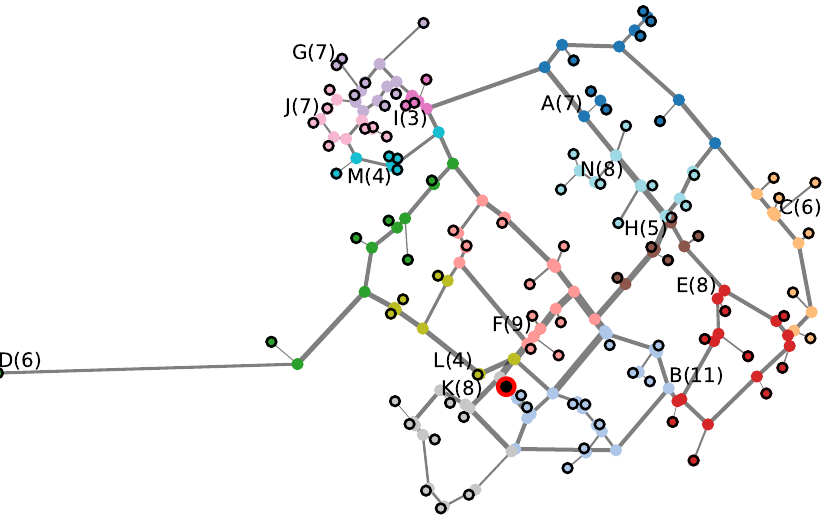
Figure 6. FZJ network structure with the identified communities highlighted and labelled; the corresponding number of included buildings is indicated in parentheses behind.